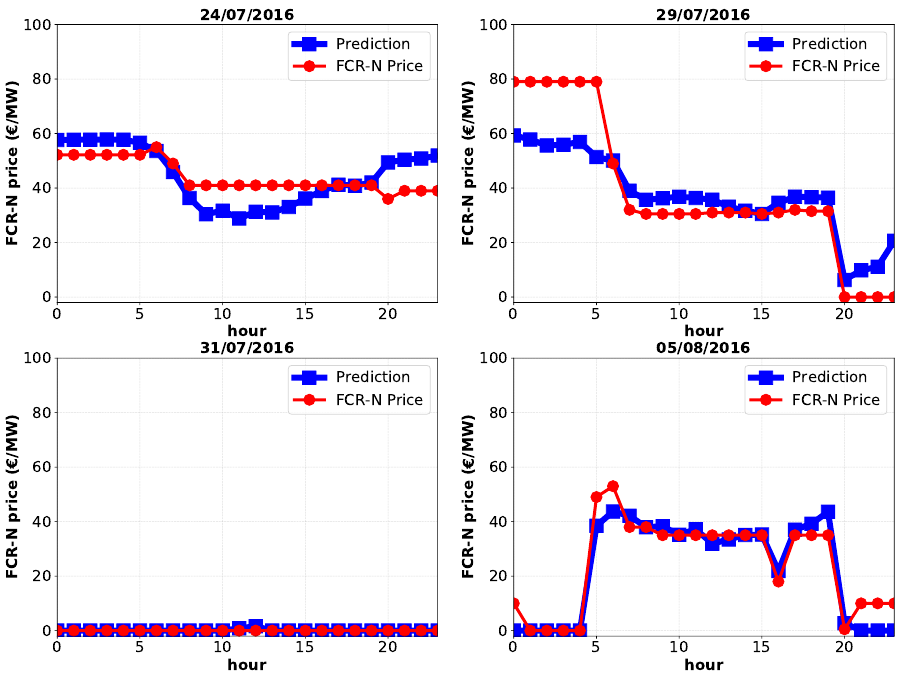
Figure 20. Examples of four days in the period July–August 2016, which have been accurately predicted by the ANN model, where in the first row, there are two outlier price patterns, while in the second row, two of the most recurring price patterns for the FCR-N market.